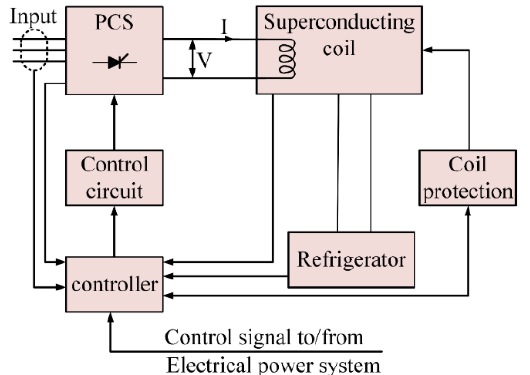
Figure 18. Schematic diagram of an super magnetic energy storage (SMES) system, which consists of four main subsystems and a protection system